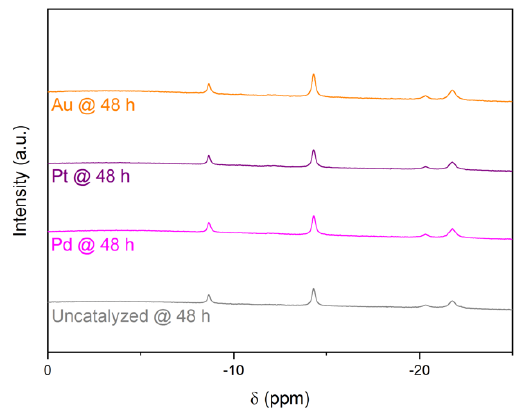
Figure 4. Proton-decoupled 11 B NMR of the 10 mL DMF solutions of BH 4− (1.32 M) hydrolyzed by 7.6 mL of alkaline (0.1 M NaOH), uncatalyzed or catalyzed by Pd, Pt, or Au after 72